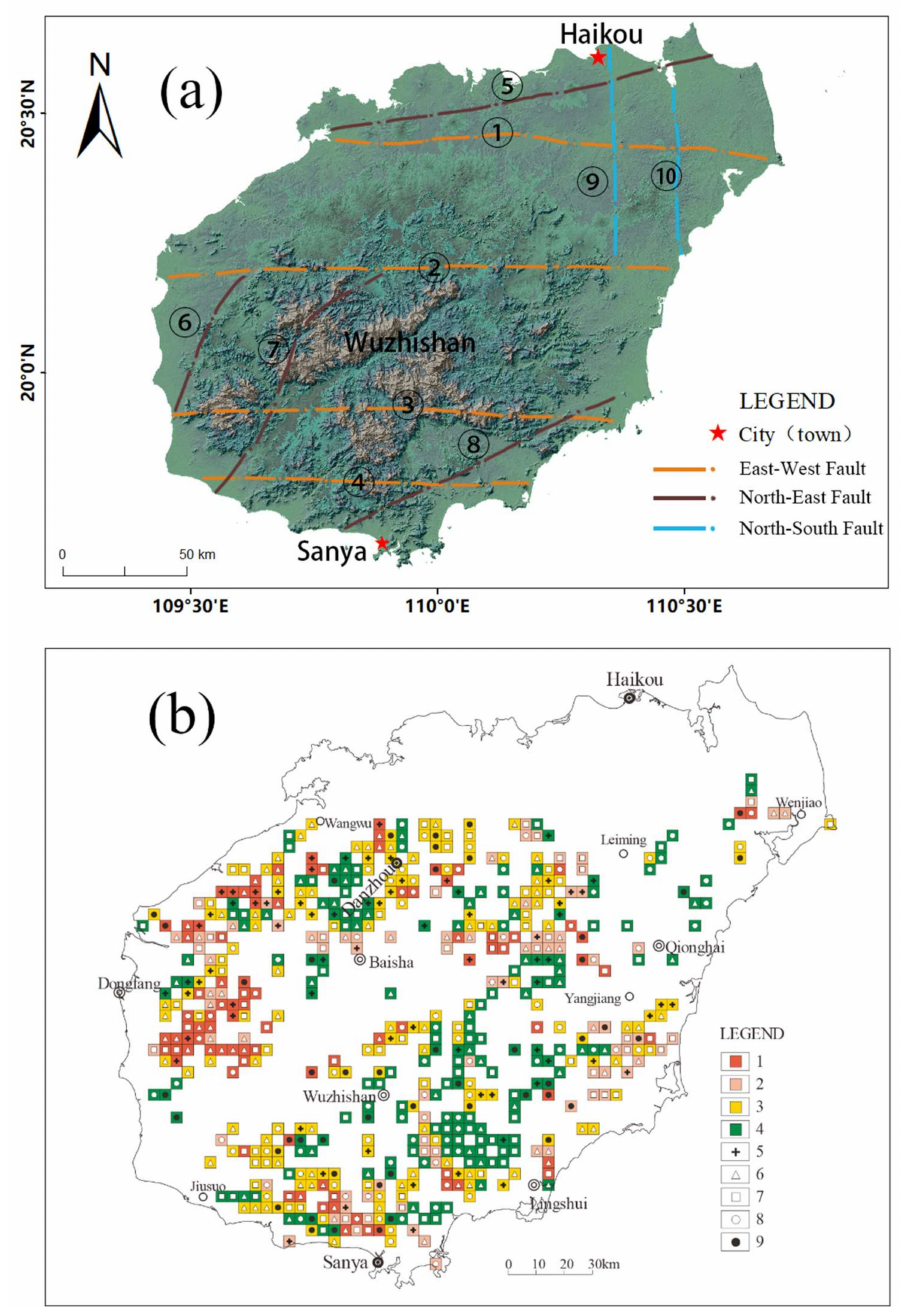
Figure 2. Distribution of major fault zones and prospecting sites of thermal mineral water on Hainan Island ( a ). Sketch of the main faults on Hainan Island ( b ). Prospective sites of thermal mineral water on Hainan Island. 1 (cid:13) Wangwu–Wenjiao fault zone; 2 (cid:13) : Changjiang–Qionghai fault zone; 3 (cid:13) : Jianfeng–Diaoluo fault zone; 4 (cid:13) : Jiusuo–Lingshui fault zone; 5 (cid:13) : Guangcun–Puqian fault zone; 6 (cid:13) : Gezhen fault zone; 7 (cid:13) : Baisha fault zone; 8 (cid:13) : Yacheng–Gangbei fault zone; 9 (cid:13) : Qiongshan– Shihe fault zone; 10 (cid:13) : Puqian–Beiao fault zone. 1: A1-level prospecting site; 2: A2-level prospecting site; 3: A3-level prospecting site; 4: B-level prospecting site; 5: predicted temperature 25–40 ◦ C; 6: predicted temperature 40–50 ◦ C; 7: predicted temperature 50–60 ◦ C; 8: predicted temperature 60–70 ◦ C; 9: predicted temperature >70 ◦